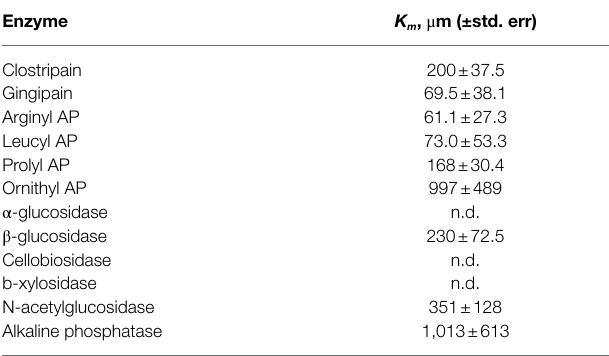
TABLE 3 | K m values for enzymes at 4.5